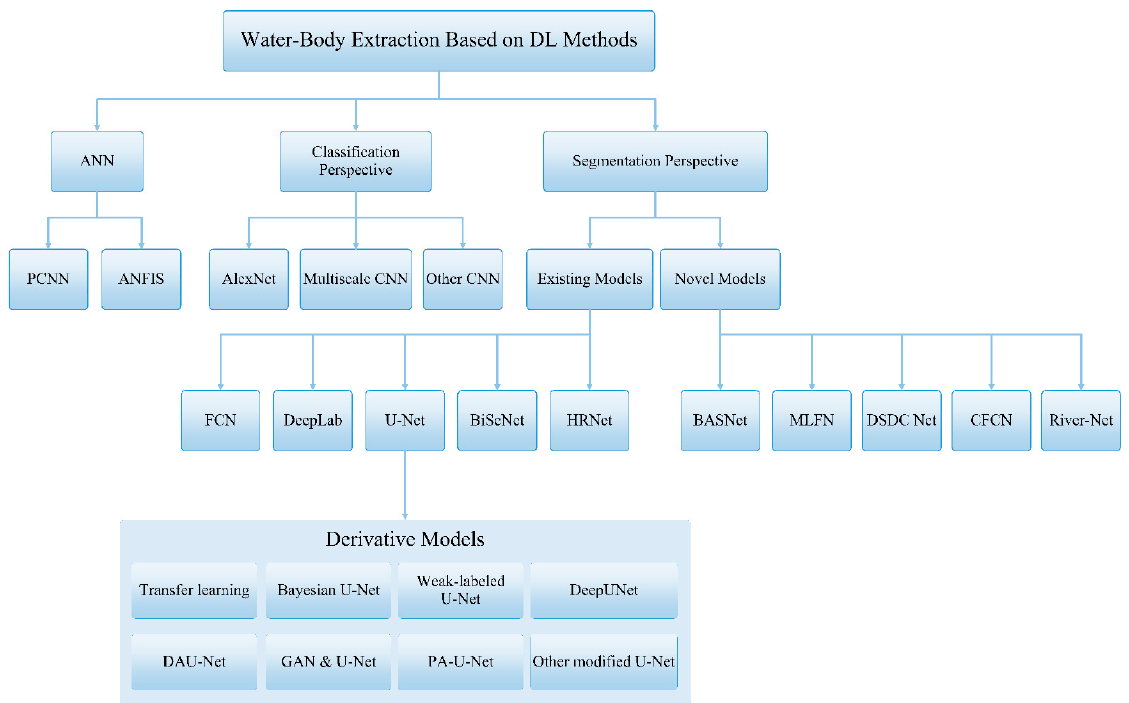
Figure 3. Water body extraction from SAR images based on